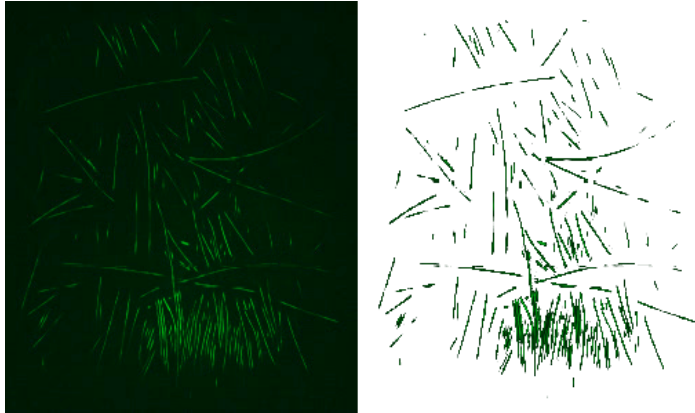
Figure 6. Example of threshold application on hair capacitive image. On the left the original frame, where acclimatized hair on bright green and air/bad contact on darker green shades. Right, the software output after a range threshold is applied to exclude pixels with bad contact before calculating water content.